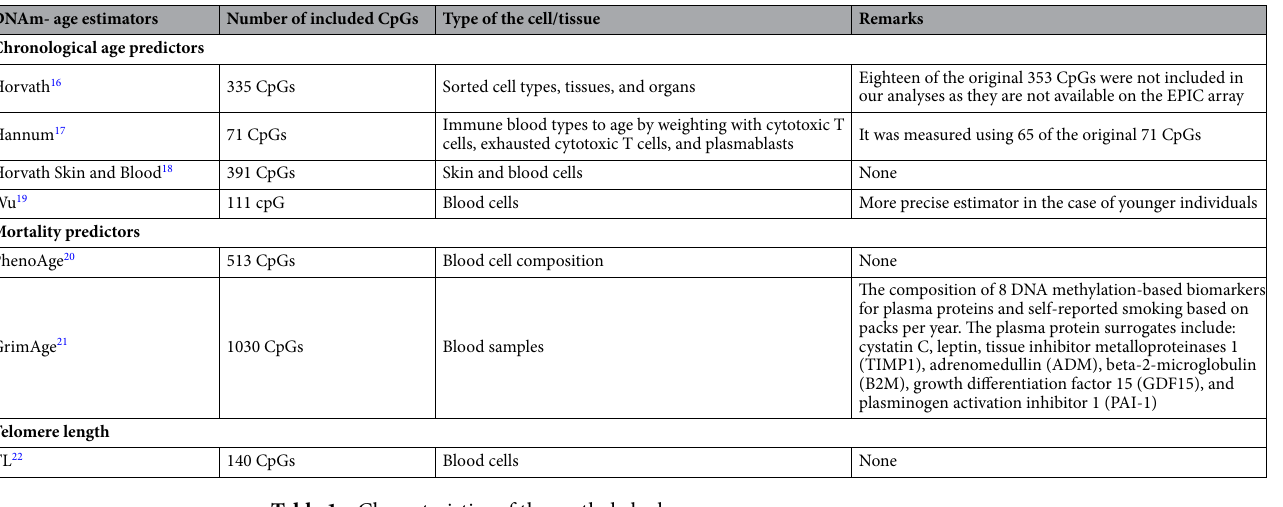
Table 1. Characteristics of the methyl